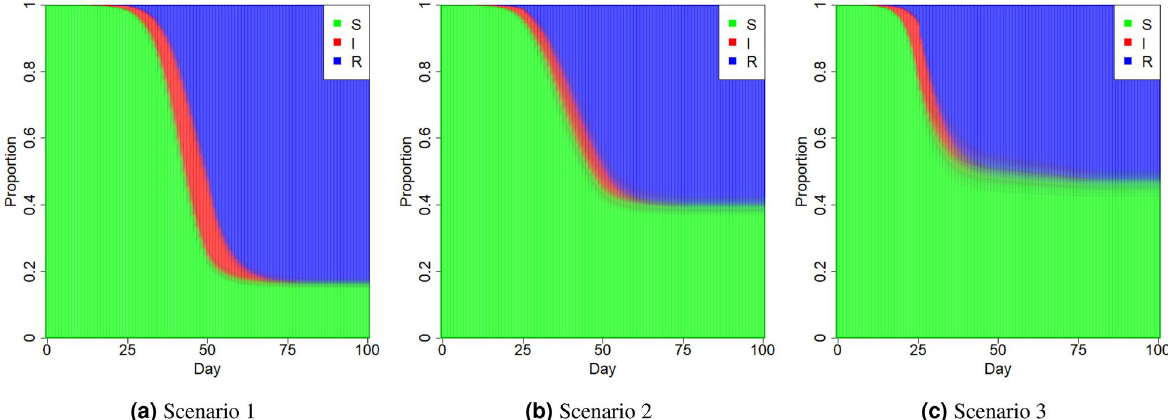
Figure 3. Average proportions of susceptible (S), infectious (I) and removed (R) individuals in the population at time t ( t = 1, . . . , 100 ) under different